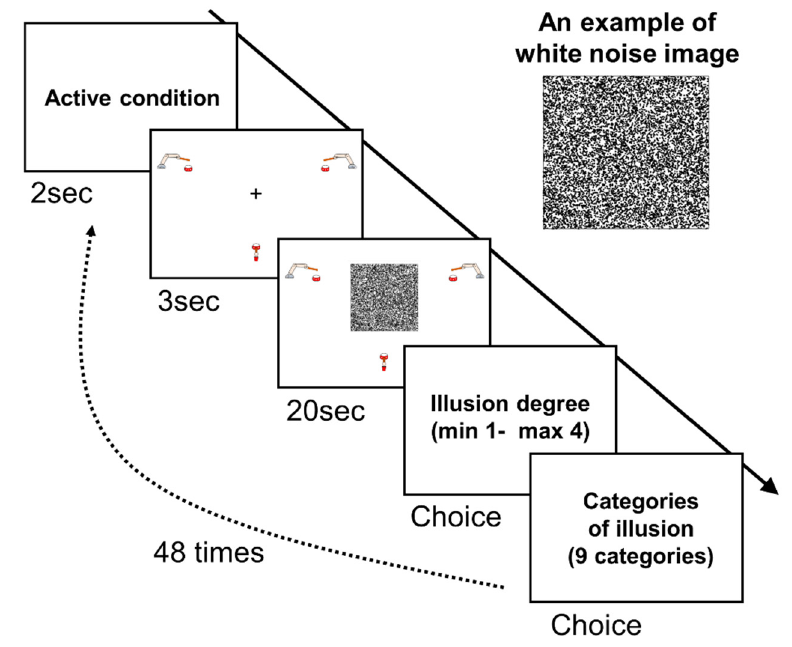
Figure 1. The experimental task displayed on the computer and an example of white noise image.